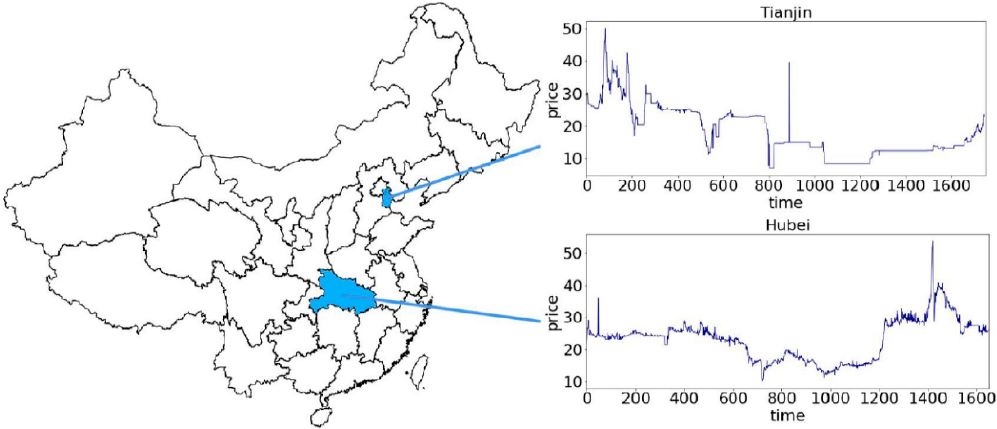
Figure 3. The location of the markets and the general view.